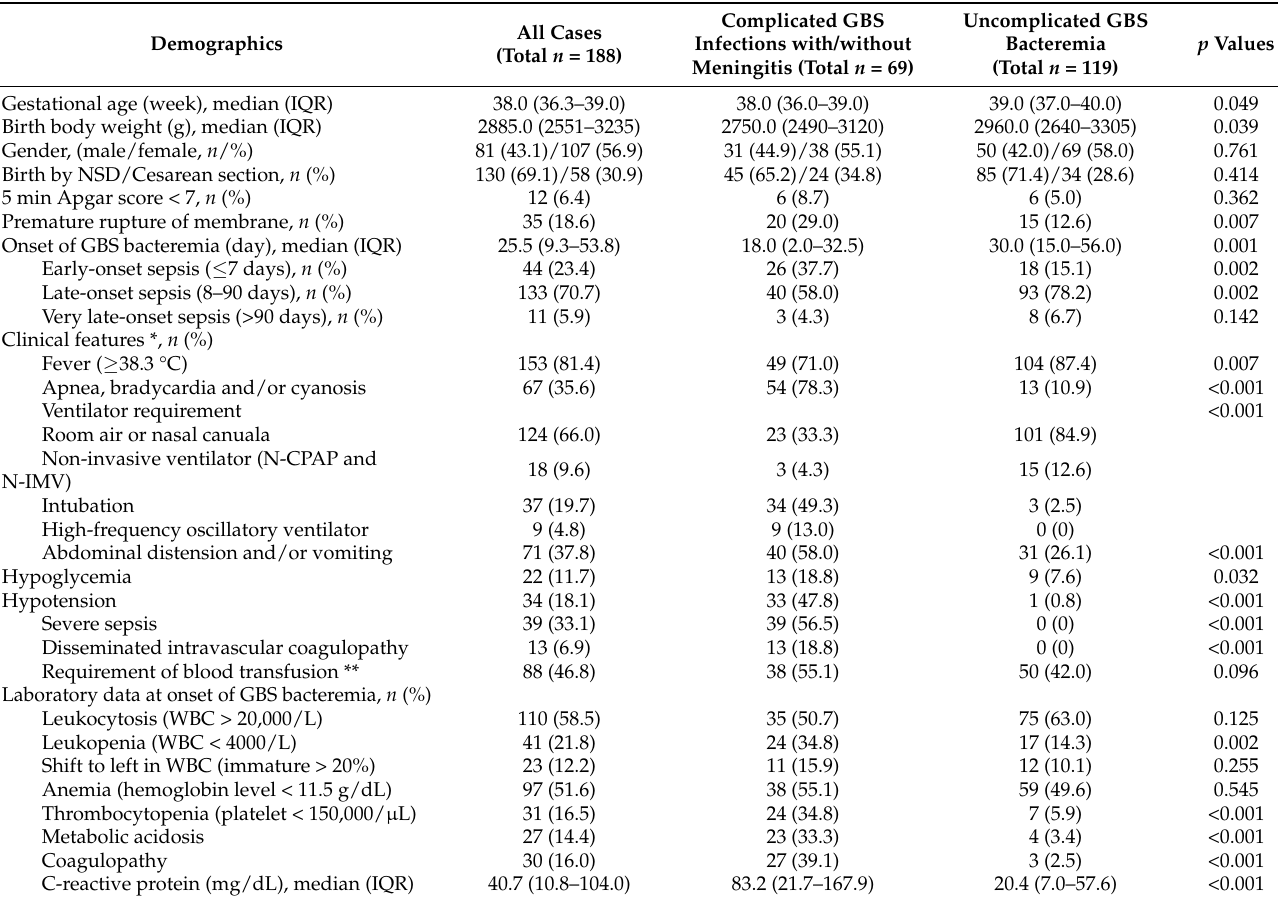
* At onset of GBS bacteremia; ** including leukocyte poor red blood cell and/or platelet transfusion. All data are expressed as number (%) or median (IQR). IQR: interquartile range; WBC: white blood cell count; N-CPAP: nasal continuous positive airway pressure; N-IMV: non-invasive mechanical